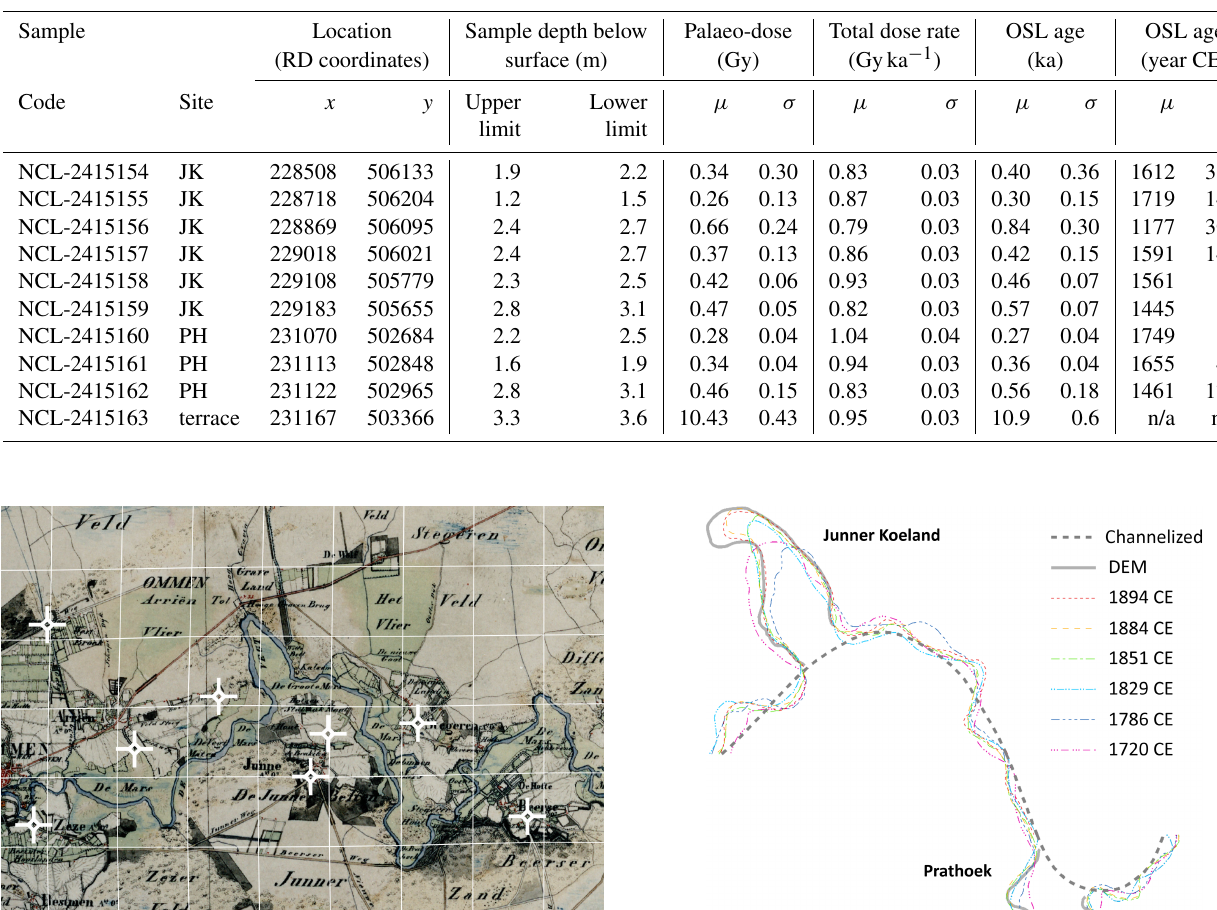
Table 3. Results of the OSL dating. JK: Junner Koeland; PH: Prathoek; RD: Dutch coordinate system (Rijksdriehoekstelsel). Palaeo-doses and ages are based on the bootstrapped Minimum Age Model for all samples from scroll bar deposits (JK and PH) and the Central Age Model for the terrace sample; n/a: not applicable.